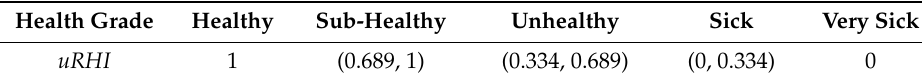
Table 4. Standard level of health status for the Jialu River.